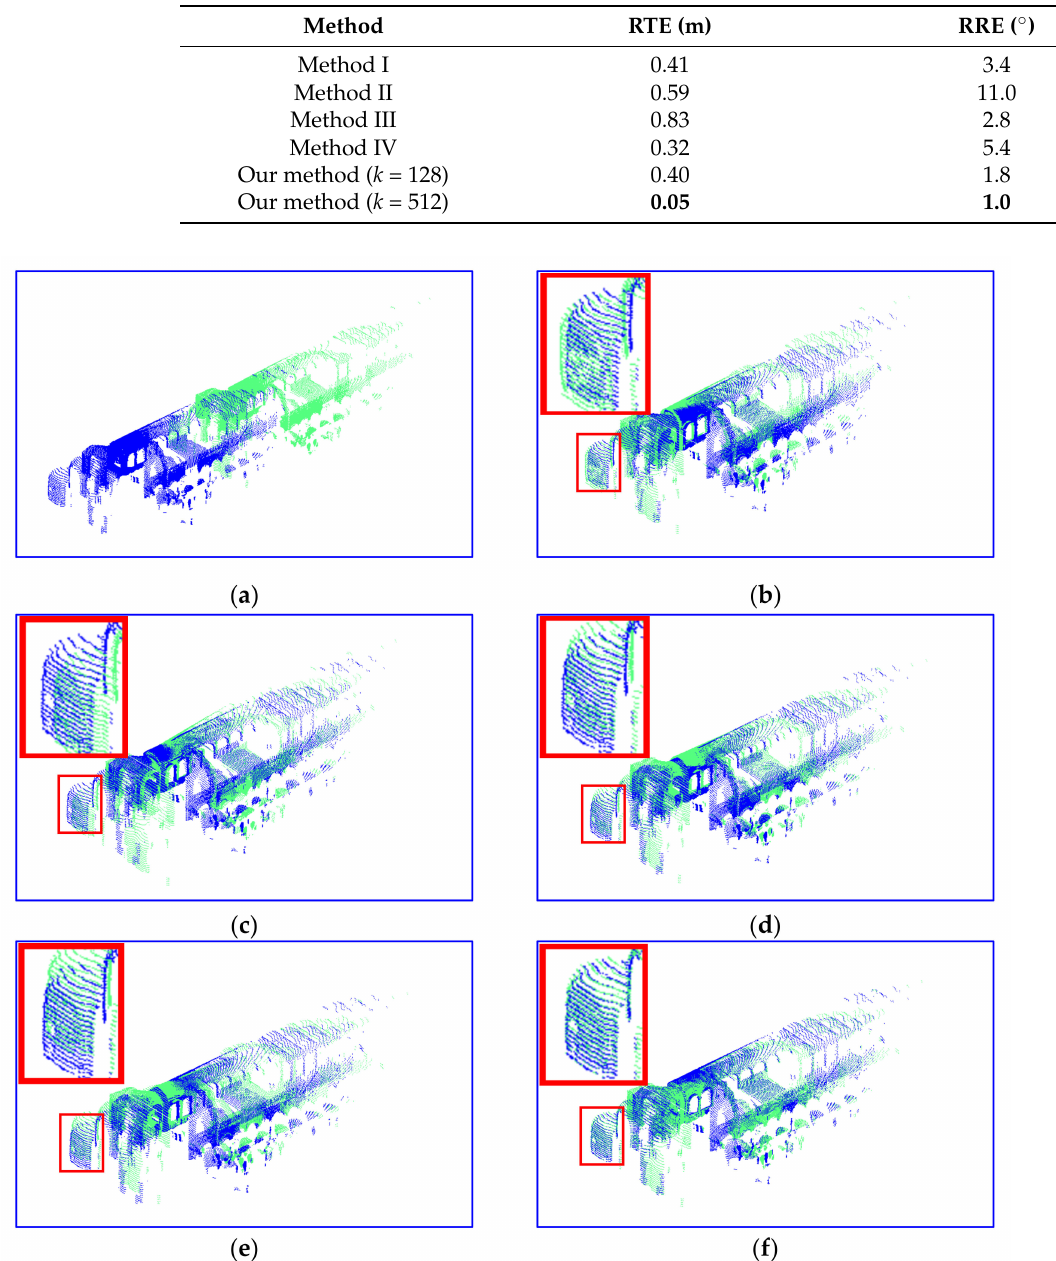
Figure 5. The registration results of each method in Dataset I (scan #34 and scan #33). The red box in the upper left of each subfigure is an enlarged view of the corresponding small red box. ( a ) The original two scans; ( b ) Method I; ( c ) Method II; ( d ) Method III; ( e ) Method IV; ( f ) our method ( k =